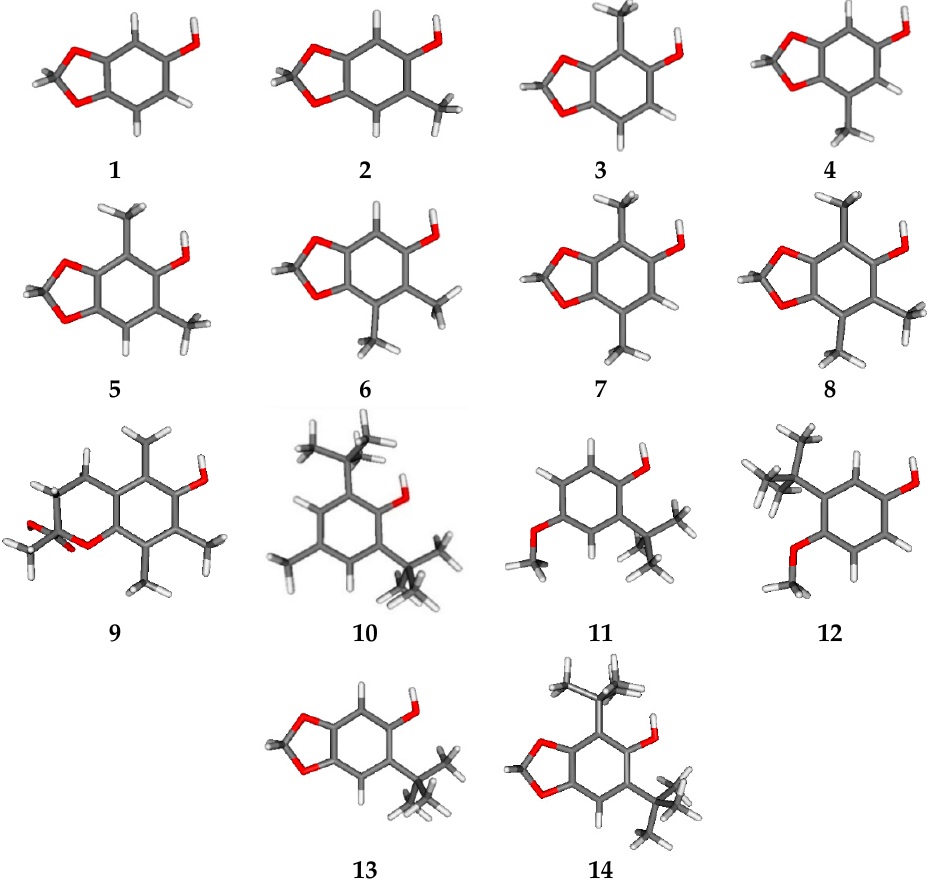
Figure 1. Optimized structure of sesamol, related alkylated derivatives, and classical antioxidants by the B3LYP/ 6-31+G(d,p) basis set (carbon = gray; hydrogen = white; and oxygen = red).